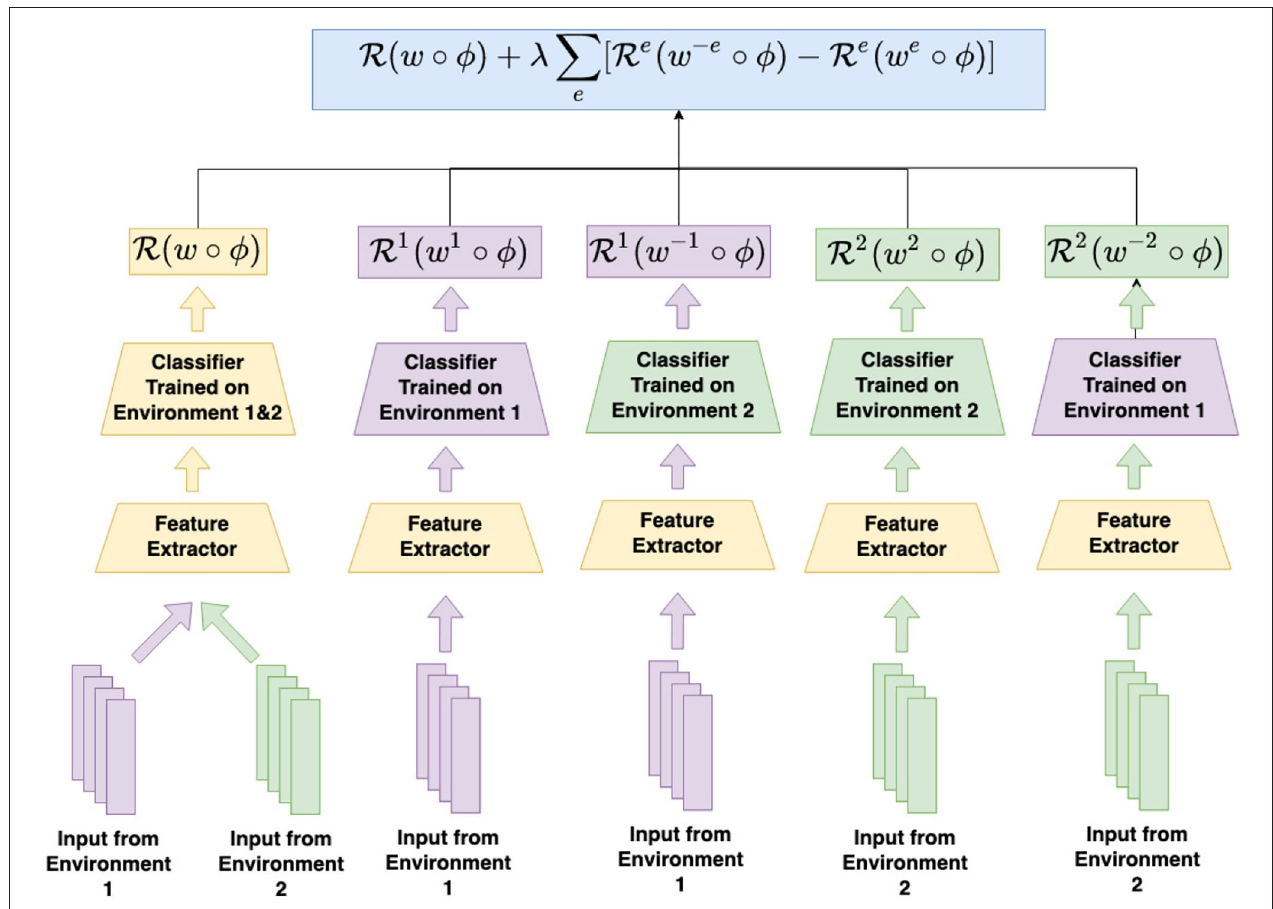
FIGURE 2 | How to compute the risk for regret minimization in a two-environment setting. In addition to the ERM risk calculated on inputs from both environment under the shared feature extractor and classifier, regret minimization inserts an additional regret term for each environment into the total risk. The regret for environment 1, for example, can be calculated by first feeding the inputs from environment 1 into the feature extractor, and then into the classifier trained on environment 1, as well as the classifier trained on all environments except environment 1. The difference calculated from the corresponding loss term for the out-of-environment classifier and the within-environment classifier is the regret. The same calculation can be done to calculate the regret for environment